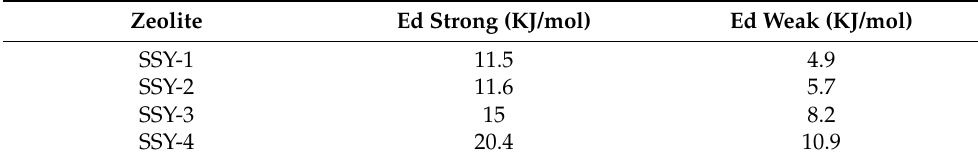
Table 4. The ammonium hexafluorosilicate modified zeolites E d value obtained from the slope of the best-fitting curve.